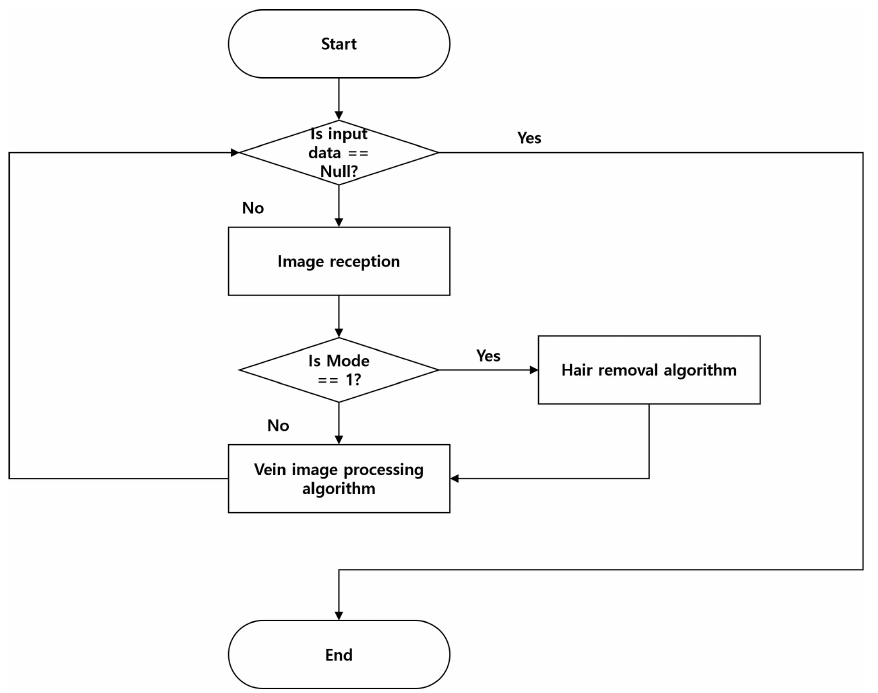
Figure 8. Flowchart of the proposed vein image processing algorithm.